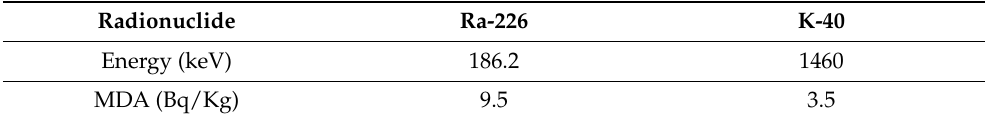
Table 3. The minimum detectable activity of the radionuclides of interest.